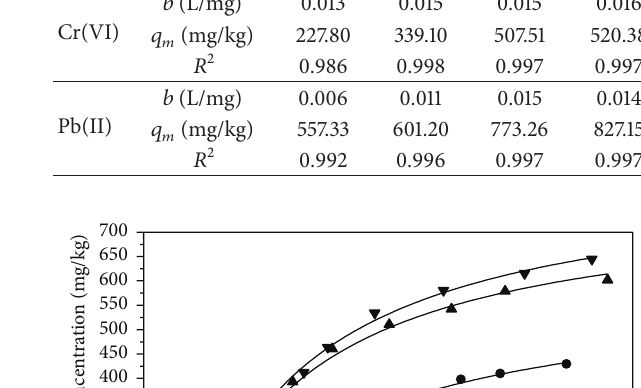
Figure 3: The adsorption isotherm for Cr(VI) with modified clay.